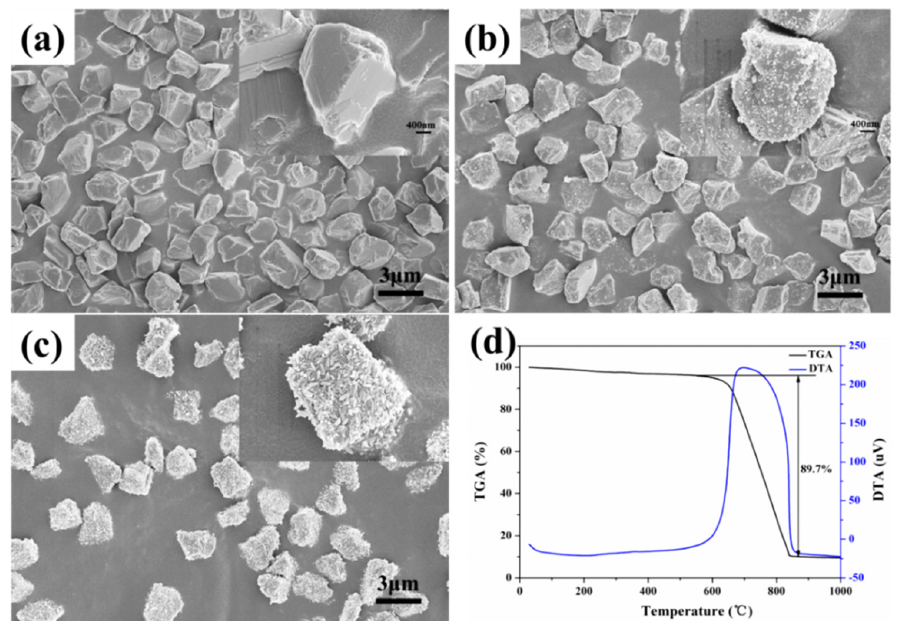
Figure 2. Morphologies of diamond/akageneite hybrid particles under different reaction durations: